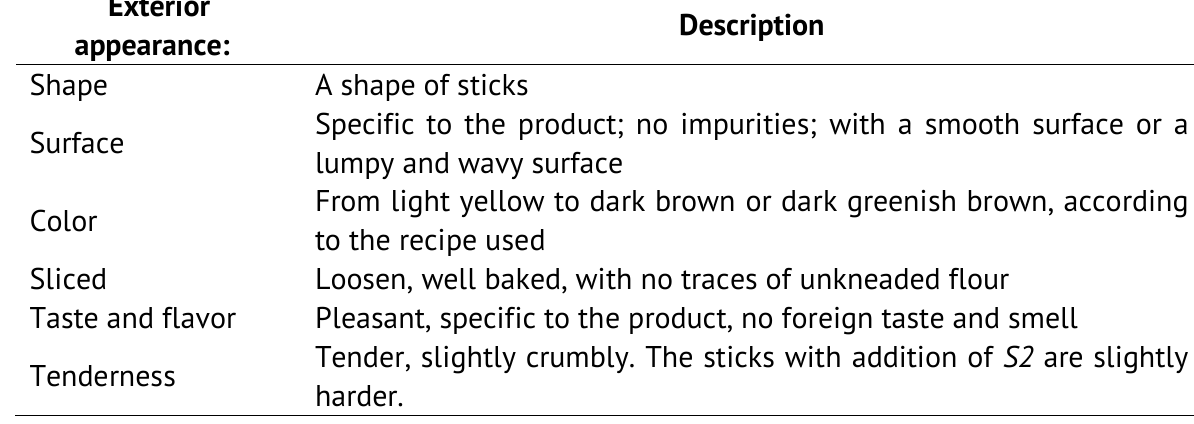
The sensorial characteristics of sticks [38,